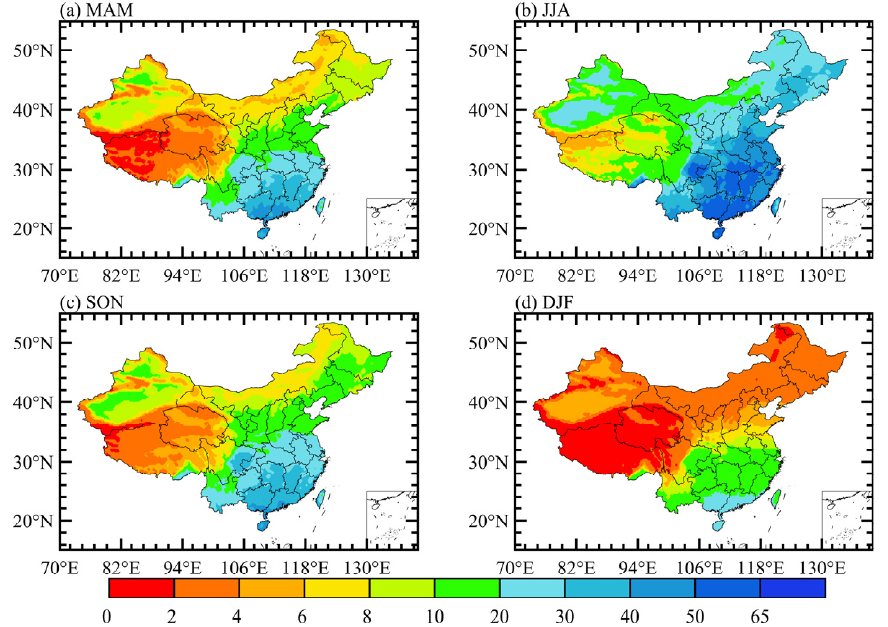
Figure 2. Spatial distribution of seasonal average atmospheric precipitable water (PW) over China during 1979–2020 (unit: kg·m − 2 ). ( a ) Spring, ( b ) Summer, ( c ) Autumn, ( d ) Winter.